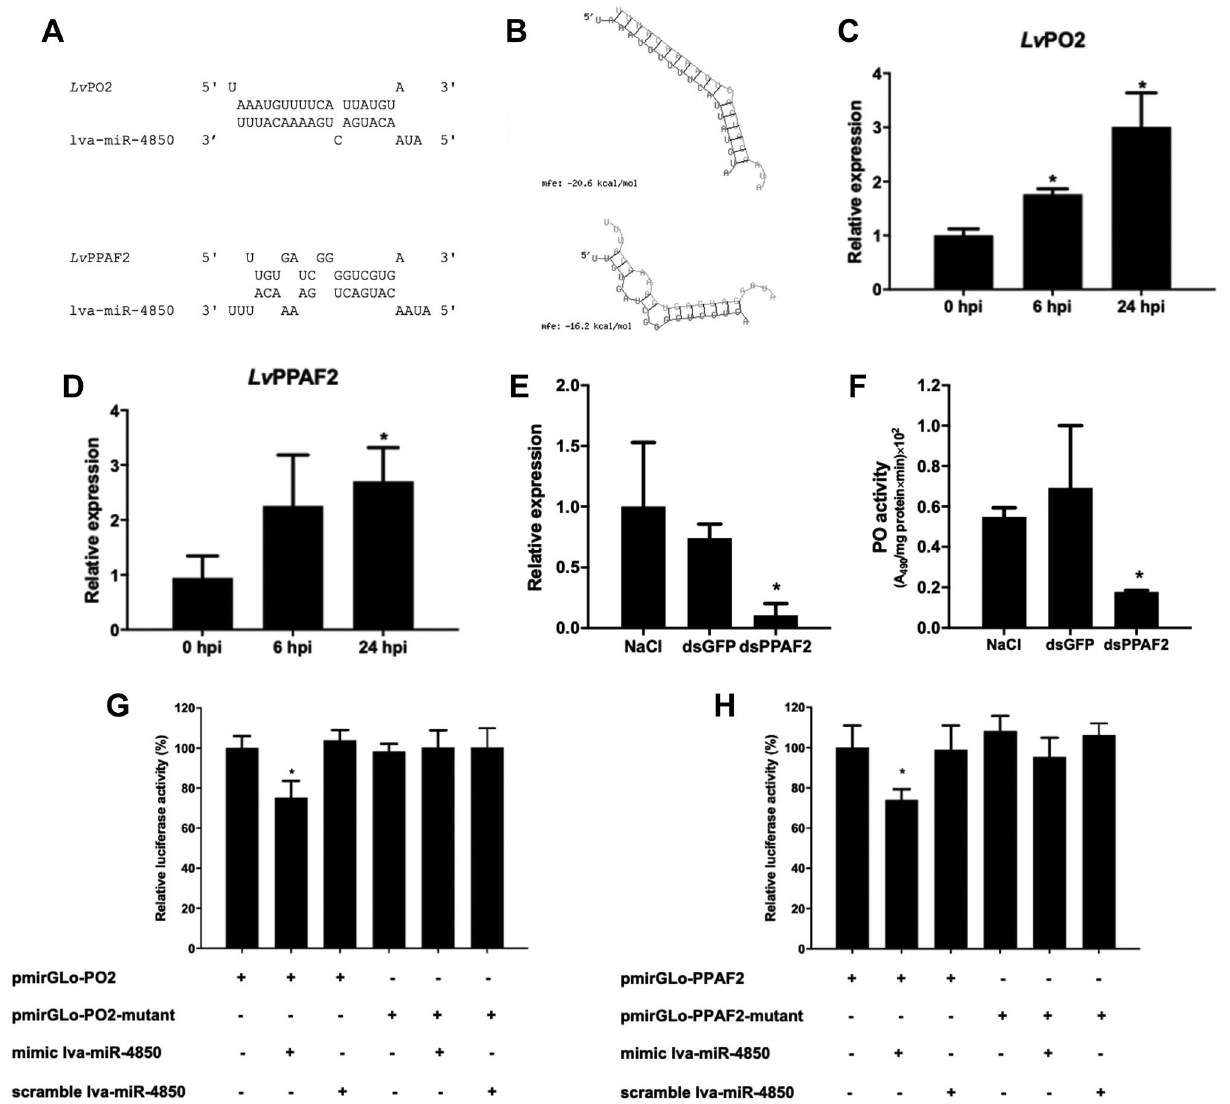
Figure 3. The lva-miR-4850 target identification. ( A , B ) Binding of lva-miR-4850 to target mRNA, as predicted using the ( A ) in-house and ( B ) RNAhybrid software. ( C , D ) Relative expression levels of ( C ) PO2 and ( D ) The expression of PPAF2 , the mRNA targets of lva-miR-4850, in response to VP AHPND infection in P. vannamei hemocytes. Relative expression levels were determined by qRT-PCR and standardized against EF-1α as the internal control. ( E ) The efficiency of the PPAF2 knock-down, shown as the PPAF2 expression level, in shrimp hemolymph at 48 h post dsRNA injection relative to EF-1α expression as an internal control. ( F ) The PO activity of shrimp hemolymph was determined in the PPAF2 knock-down shrimp (dsPPAF2) compared with the control groups (NaCl and GFP-dsRNA injection). ( G , H ) Synthetic mimic lva-miR-4850 or scramble lva-miR-4850 were co-transfected with the pmirGLO-target or pmirGLO-target-mutant into HEK293-T cells in order to confirm the interaction of lva-miR-4850 with ( G ) PO2 and ( H ) PPAF2 . Luciferase activity was measured at 48 h after transfection. Data are shown as the mean ± 1 SD, derived from three independent repeats. Asterisks indicate significant differences at P < 0.05 miR-4850 and 0.85% (w/v) NaCl-injected shrimps. The transcription levels of PO2 and PPAF2 exhibited a nega- tive correlation to that of lva-miR-4850, as expected. The PO2 and PPAF2 expression levels were significantly decreased (approximately 4- and 1.5-fold, respectively) in mimic-lva-miR-4850-injected shrimps compared to the control groups (Fig. 4A). As the PO2 and PPAF2 expression level was decreased after injection of mimic-lva- miR-4850, the corresponding proPO activity was significantly (about twofold) decreased when compared to the control groups (Fig. 4B). On the other hand, shrimps injected with AMO-lva-miR-4850, to inhibit lva-miR-4850, and then challenged with VP AHPND exhibited a significant (approximately two-fold) reduction in the lva-miR-4850 expression level compared to the control groups. Considering the PO2 and PPAF2 expression levels, an inverse relationship between lva-miR-4850, PO2 , and PPAF2 was observed . The PO2 and PPAF2 expression levels were significantly